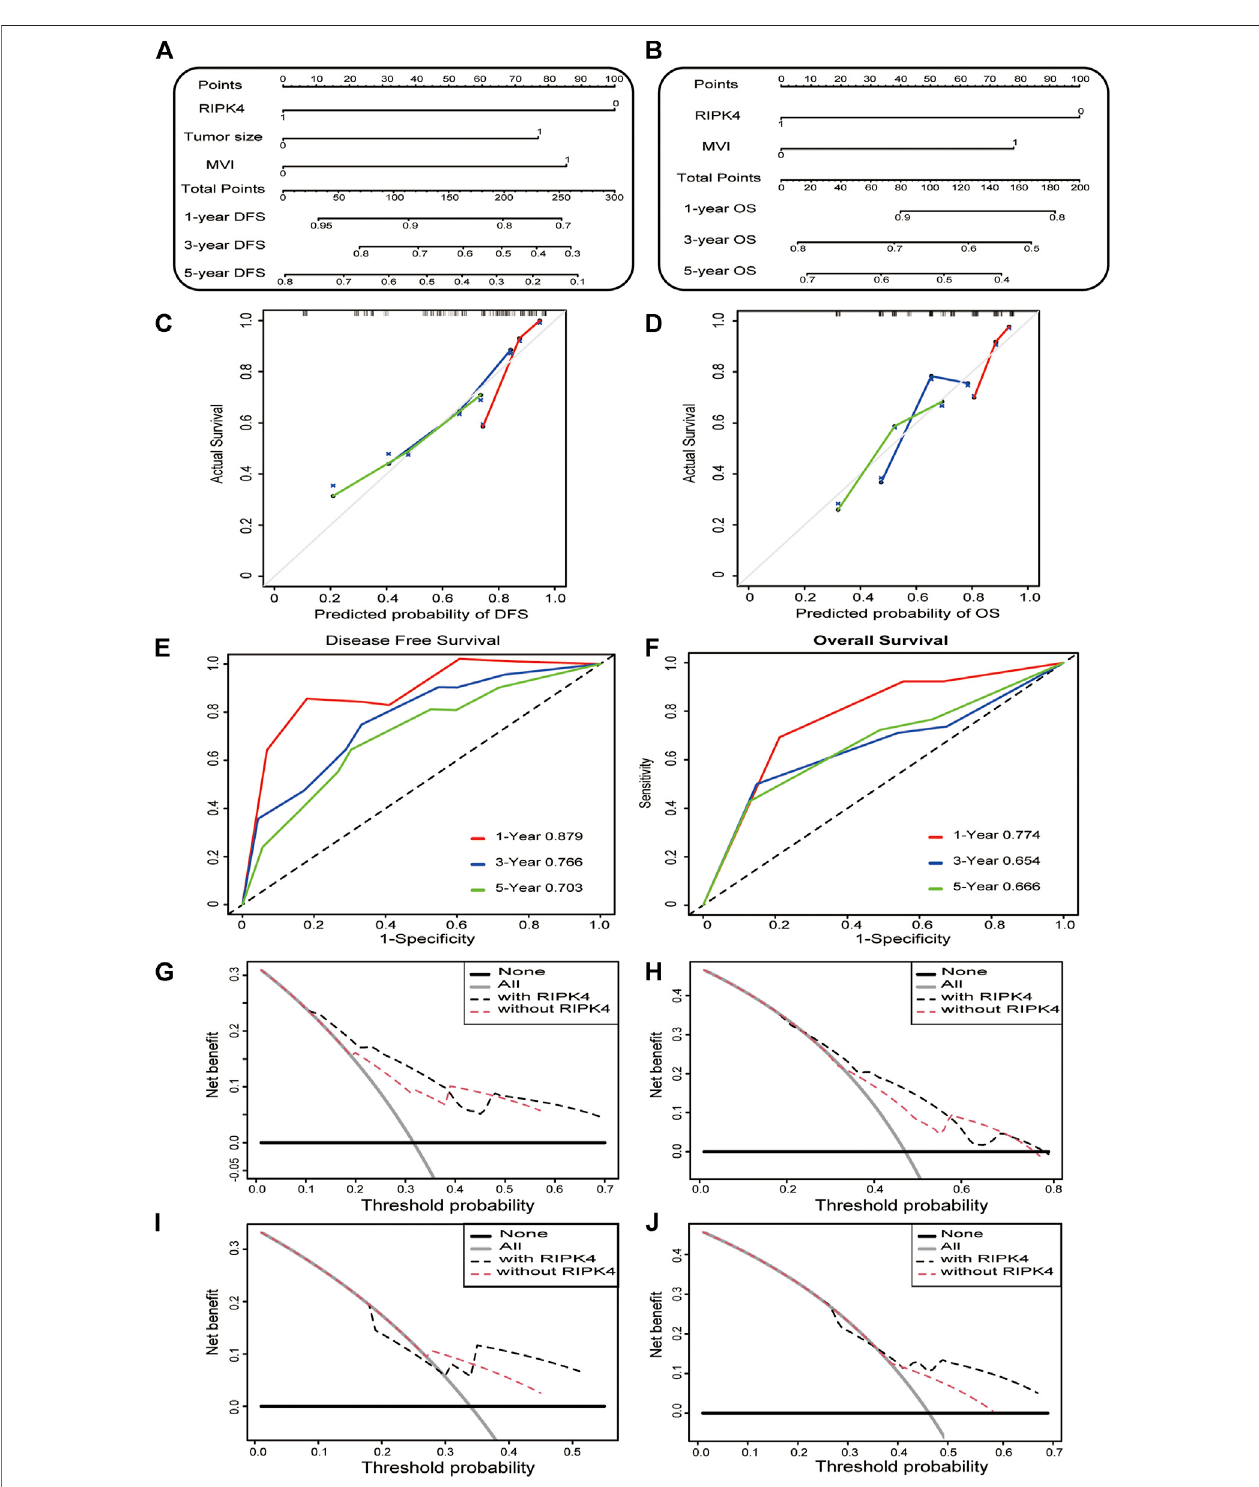
FIGURE2| Constructionandcalibrationofnomogrammodel.a-b.NomogramdevelopedtopredicttheincidenceofDFS (A) andOS (B) inHCCat1,3and5 years (C,D) Thecalibrationcurveshowingthepredictiveaccuracyofthe1-year,3-years,and5-yearsDFSrate (C) andOSrate (D) ofHCCpatientsinthestudy. (E,F) TheROC curve shows the 1, 3, and 5-years DFS (left) and OS (right) ratios in the study. (G – J) The DCA curve of the clinical utility of the 3-years (G) and 5-years DFS (H) nomogram in the study. DCA curve shows the clinical utility of the 3-years and (I) 5-years (J) OS nomogram in the study.